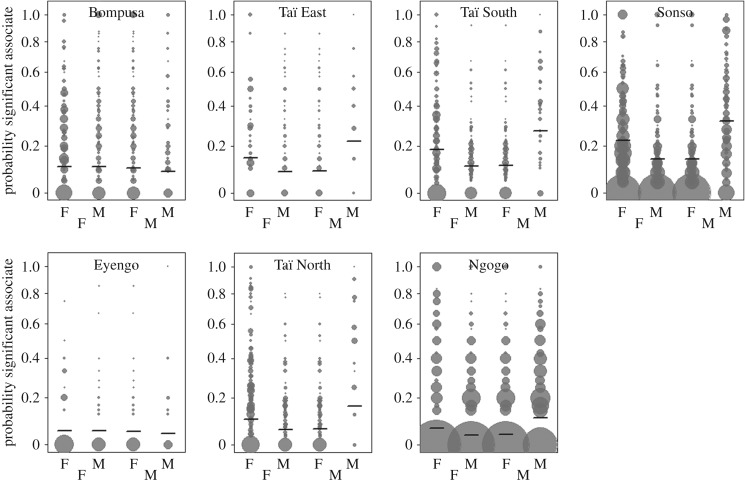
Proportion of three-month periods that a given dyad was significantly associated, separately for each sex combination (for each graph from left to right: females towards females, females towards males, males towards females and males towards males). Each dot represents a dyad and the area of the dot is proportional to the number of three-month periods during which a given dyad was observed. The horizontal segments indicate the fitted value resulting from Model 2b (controlling for maternal kinship and stability of association).